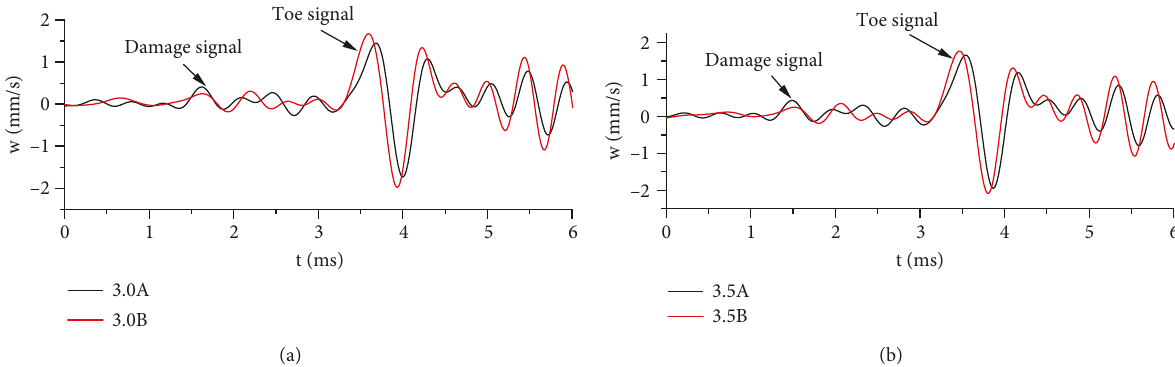
Figure 22: Upward velocities of different sensor locations. (a) Upward velocities of A velocities of A i and B i (sensor location Z s